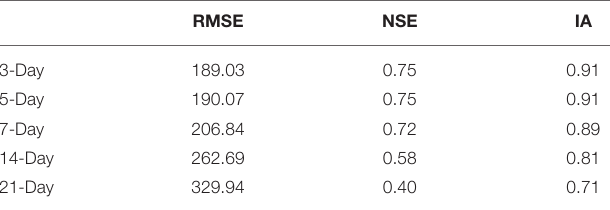
TABLE 3 | Performance of Niño 1 + 2 N-day prediction